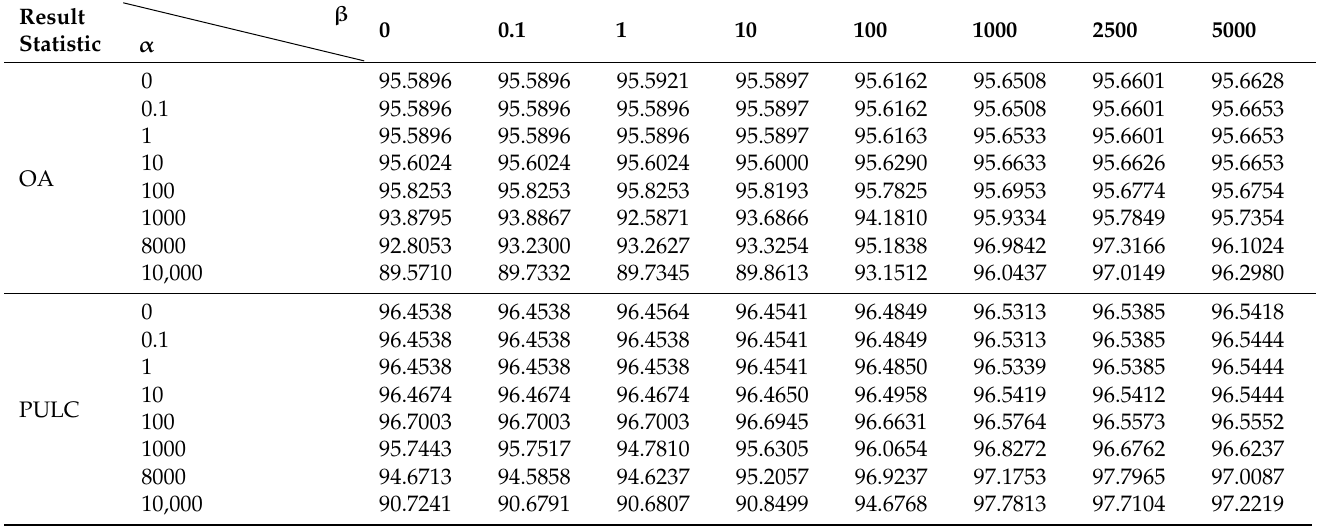
Table 4. Accuracy statistics of South Lake with Different Weighting Coefficients Based on the MESMA_MST_SRM Method